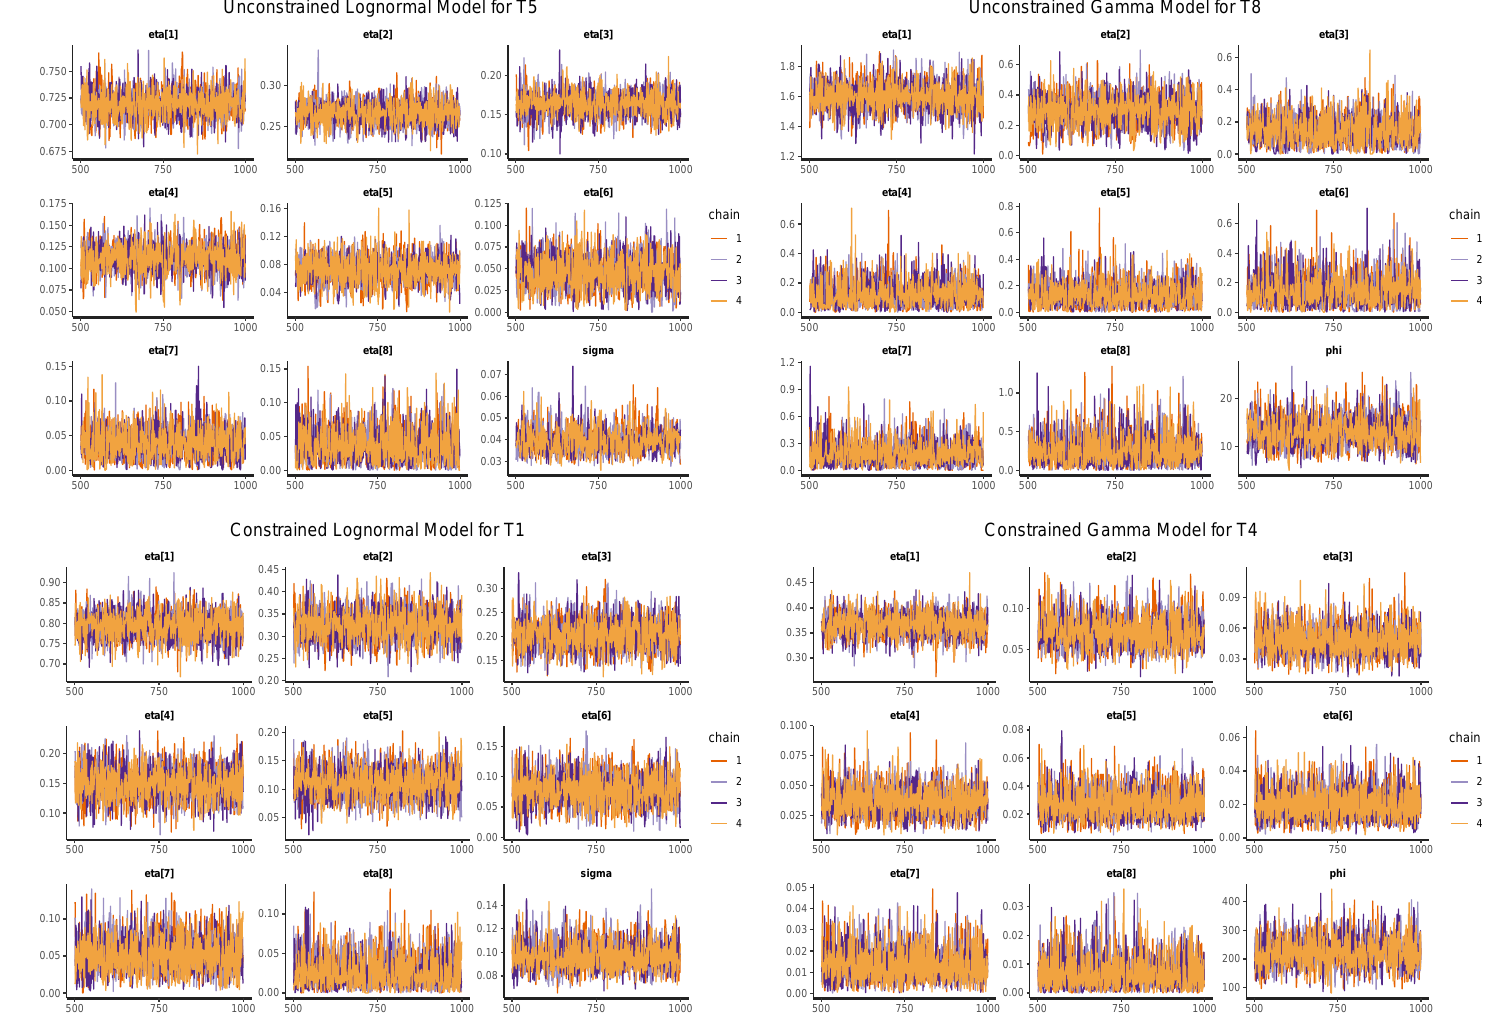
Figure A1. Randomly chosen traceplots for marginal